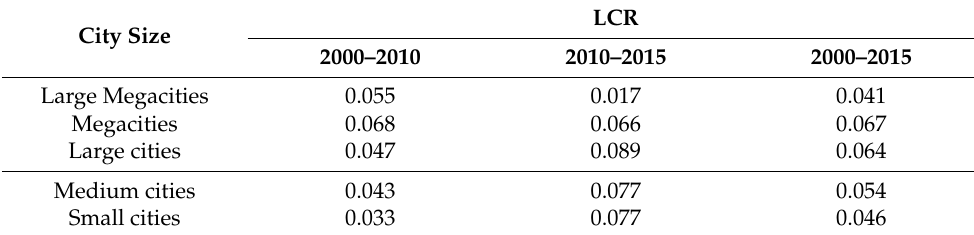
Table 2. The classification average results of land consumption